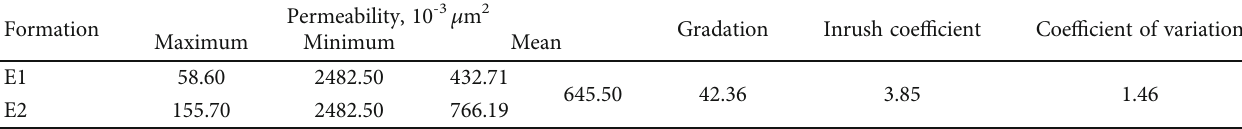
Table 8: Statistics of interlayer heterogeneity parameters of reservoirs in block Yingmai 7.